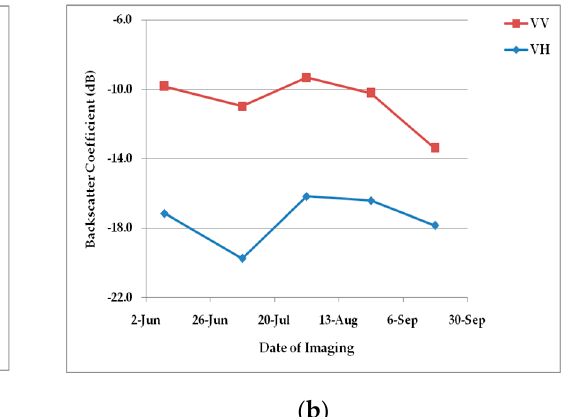
Table 4. Comparison of two-class separability results at VH and VV polarizations.